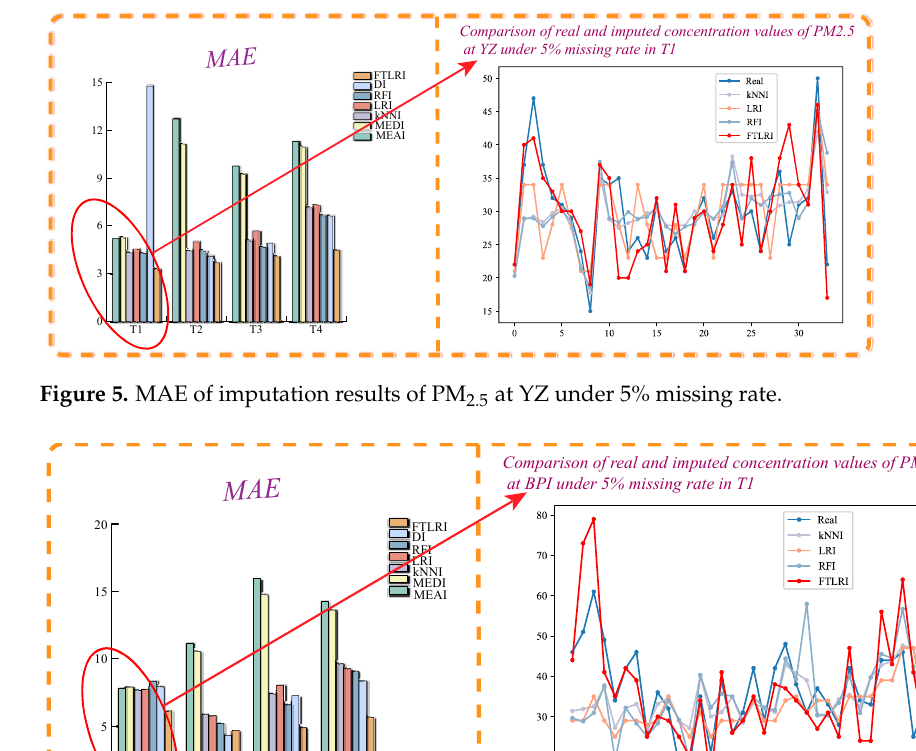
Figure 4. MAE of imputation results of PM 2.5 at LH under 5% missing rate.